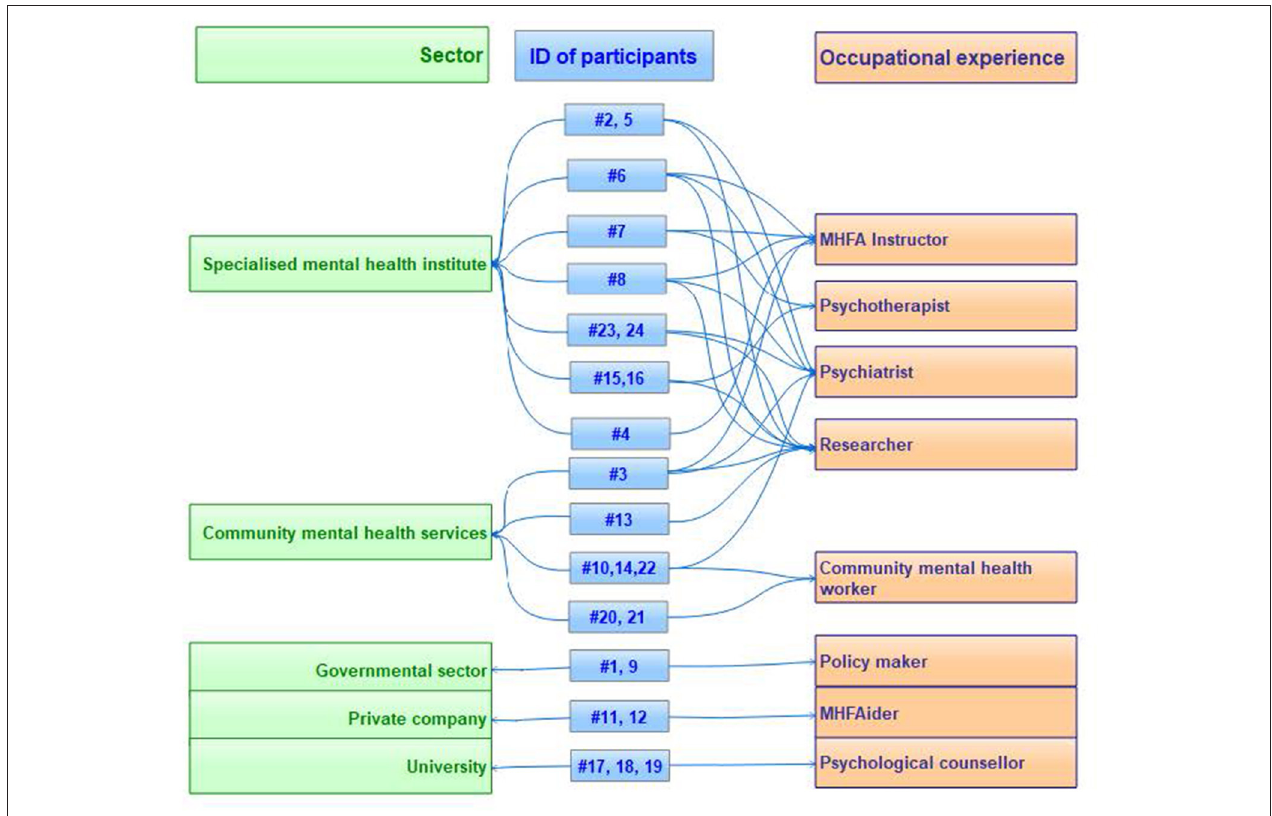
FIGURE 1 | Background and occupational experience of participants ( n =